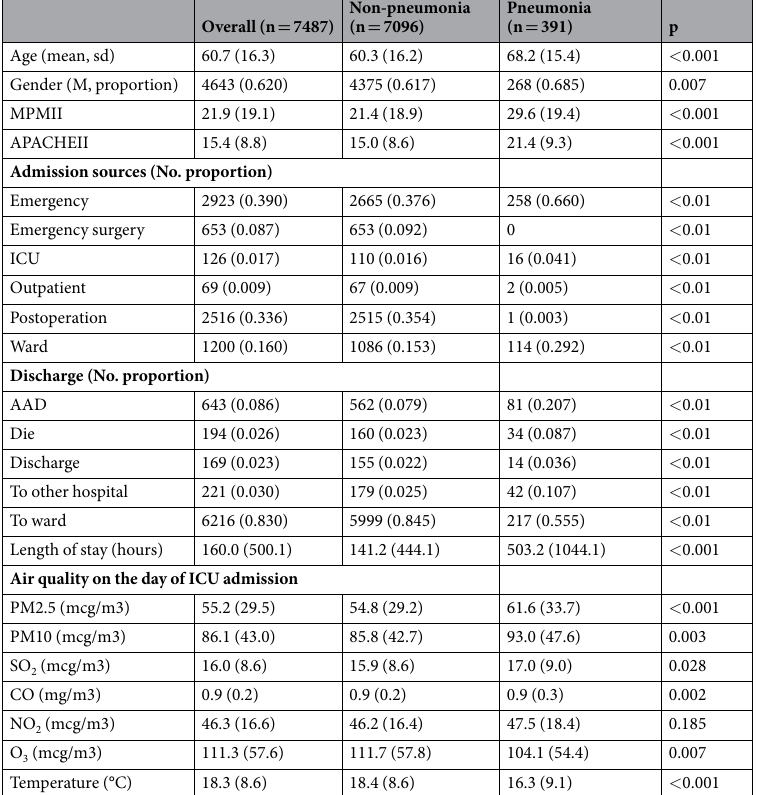
Table 1. Clinical characteristics of included patients and air quality conditions on the day of admission. Abbreviations: MPMII: Mortality Prediction Model II; APACHEII: Acute Physiology and Chronic Health